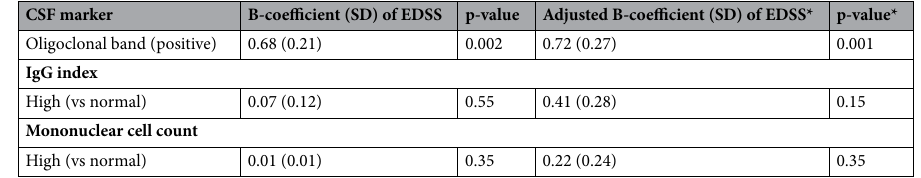
Table 5. Relationship between CSF values and disability, as measured by the EDSS (continuous), in the 5 years following baseline, using generalized estimating equations. EDSS expanded disability status scale. *Adjusted for age at sampling, time from sampling, sex region of Sweden, and time on first- and second-line DMTs.